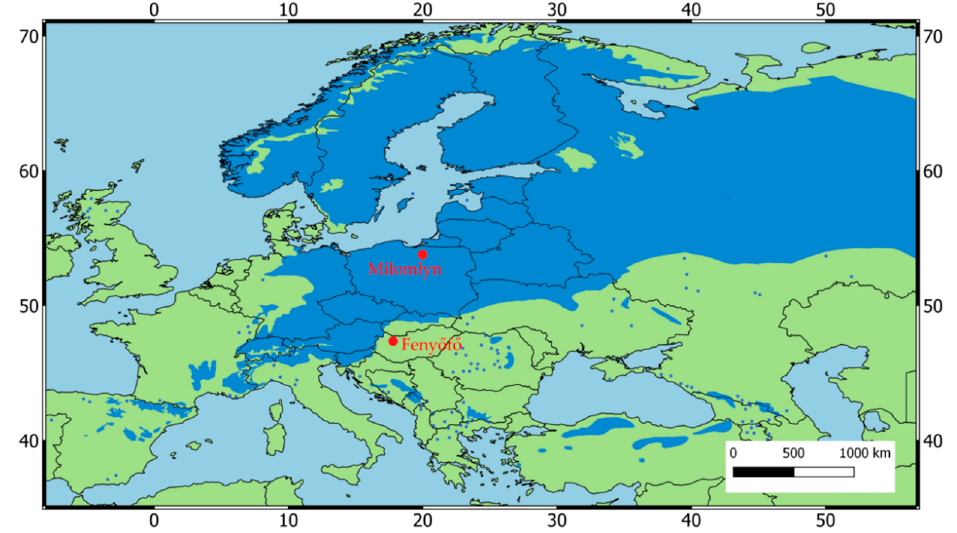
Figure 1. Distribution of Pinus sylvestris in Europe (dark blue shading) and locations of study sites (red circles) [Courtesy of EUFORGEN, (http://www.euforgen.org/species/pinus-sylvestris/)].